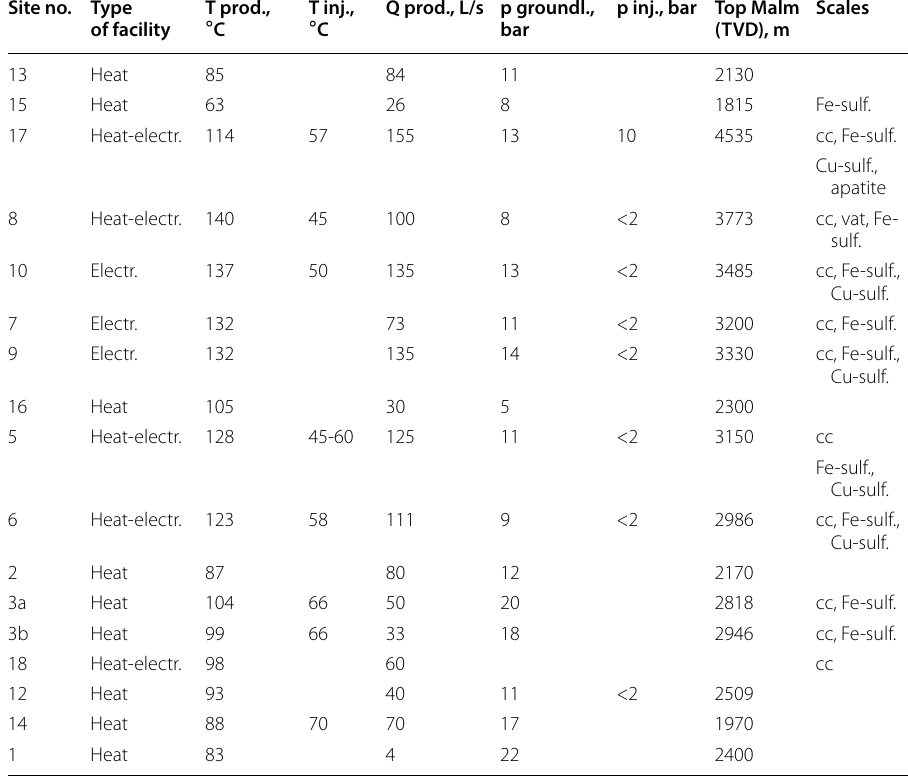
Table 1 Occurrence of scales at geothermal facilities in the BMB indicating operational parameters, sorted by water groups according to Table